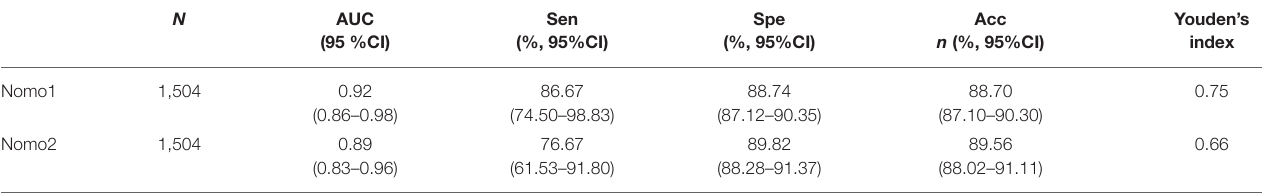
TABLE 3 | The nomograms in predicting the COVID-19 mortality with external datasets ( N = 1,504).